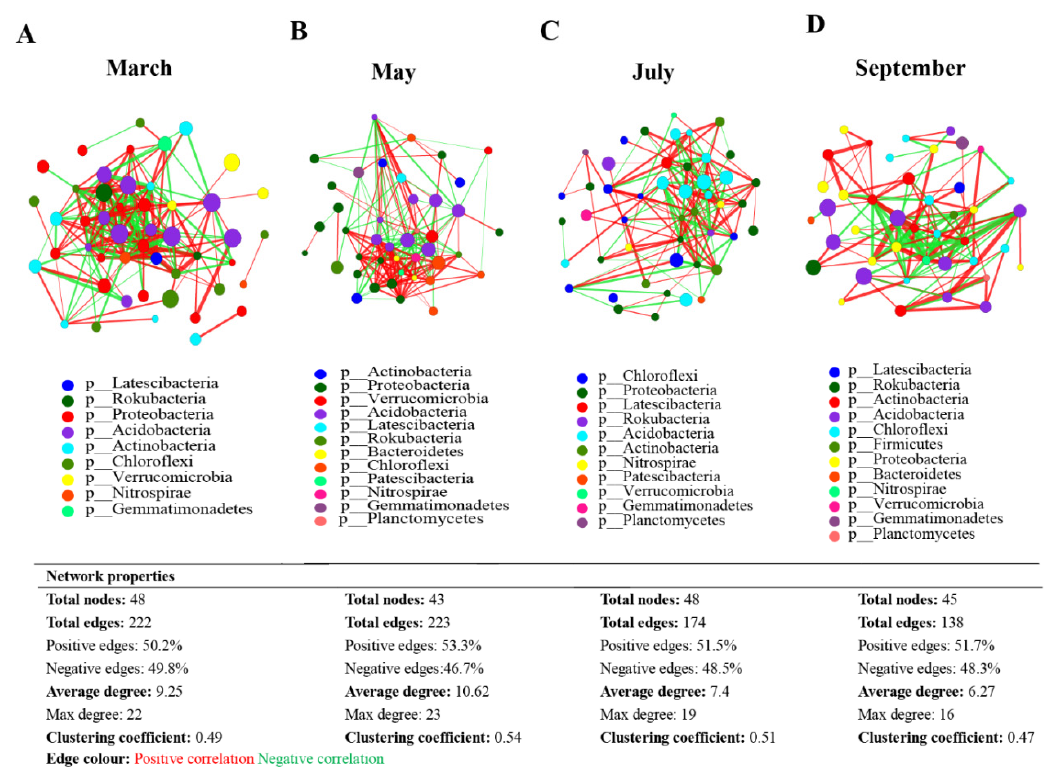
Figure 7. Co-occurrence networks and topological properties of bacteria from March ( A ), May ( B ), July ( C ) and September ( D ) soils. Nodes are colored according to microbial phylum, and the nodes with a larger size show the potential keystone genera (correlation coefficient ≥ 0.6, p < 0.01). Circle and square node shapes represent bacterial genus, respectively. Edges indicate correlations among nodes; the red and blue edges represent positive and negative correlations, respectively.